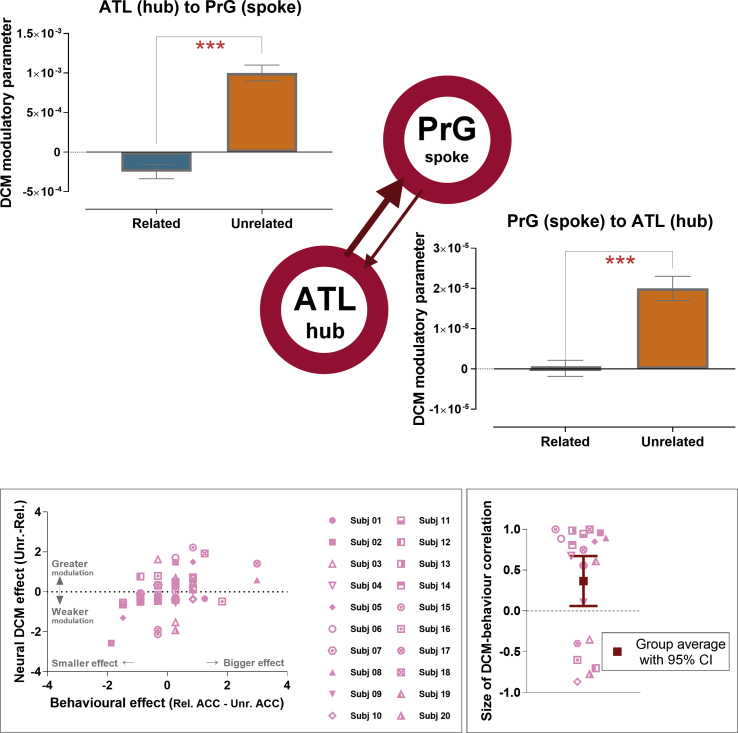
Experiment 1: Analysis of DCM on the modulatory coupling between the ATL hub and action-related spoke (the precentral gyrus). The two bar-charts show the magnitude of modulatory coupling parameters by directionality (hub-to-spoke, spoke-to-hub) and contexts (related, unrelated). The thickness of arrow in the diagram depicts the outcome that the hub-to-spoke connection was more modulated by contexts. Below the diagram: (i) The left inset-box describes the size of behavioural congruency effect (the difference in accuracy of related vs. unrelated context) in relation to the effect at neural level (the difference in DCM modulatory parameters, related vs. unrelated). This contains 60 data-points (20 participants × 3 runs of scanning). For illustrative purpose, the values are normalised, transformed to standard Z-scores. (ii) The right inset-box describes the values of DCM-behavioural correlation. This contains 20 data-points; each represents an individual's correlation across scanning runs. Note that the group's average is significantly above the chance level (no correlation).